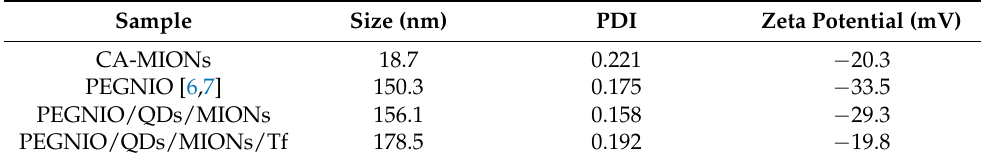
Table 1. Characteristic properties of CA-MIONs and the different PEGNIO formulations.